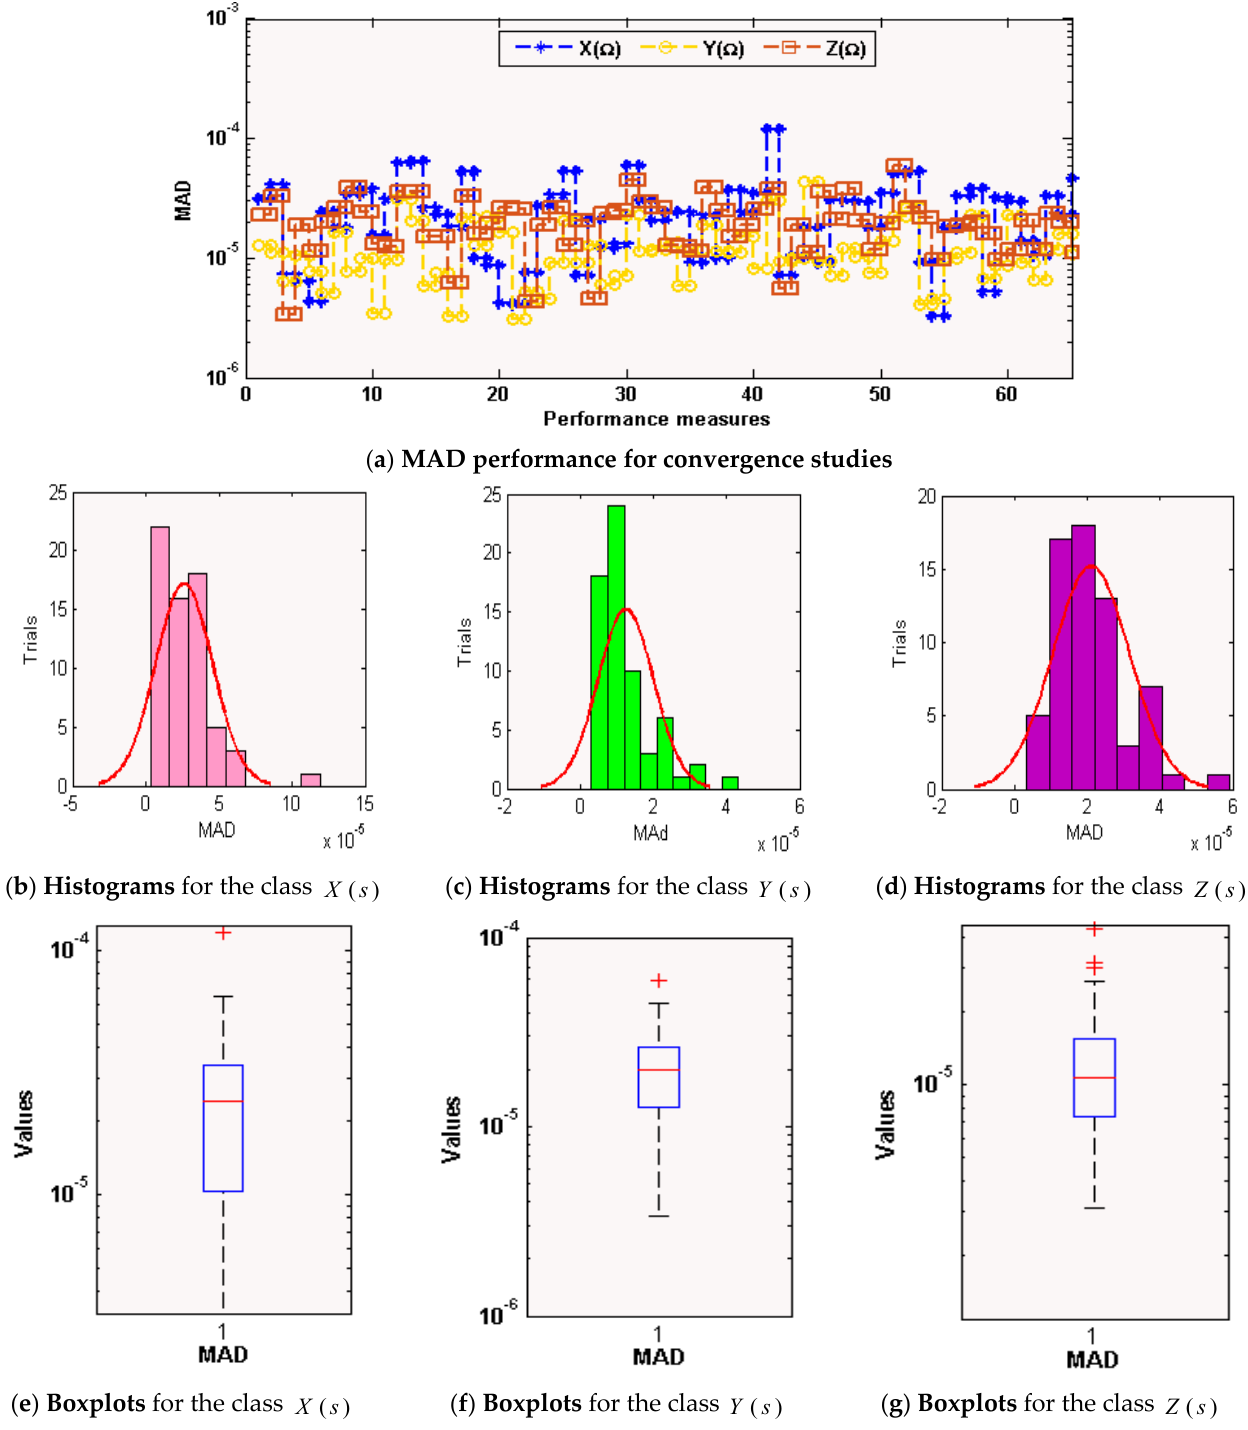
Figure 6. MAD operator performances based on ANN-GA-IPA to solve the environmental and economic nonlinear model.